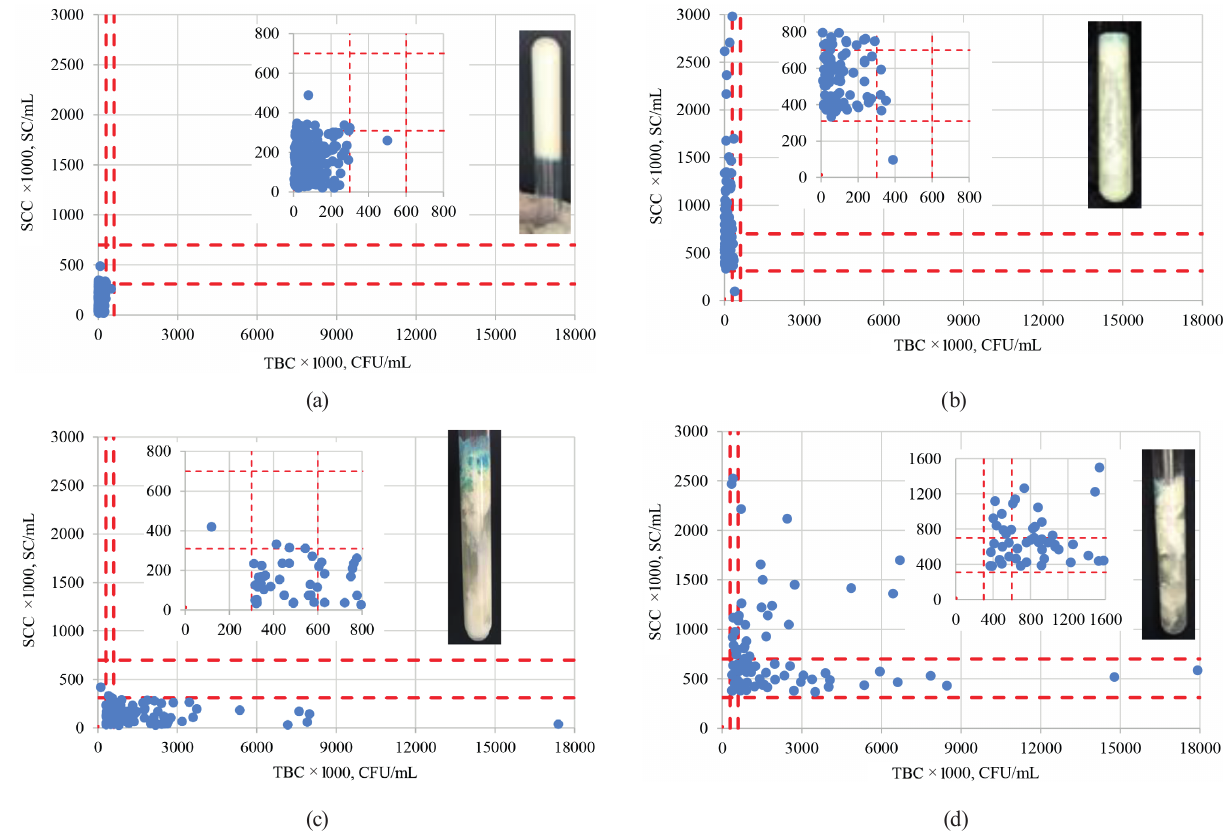
Figure 6 Correlation between the MBRTe and TBC + SCC (CFU or SC/mL, respectively). (a) MBRTe-I: n = 265 (37% of the total); (b) MBRTe-II: n = 130 (18% of the total); (c) MBRTe-III: n = 99 (14% of the total); (d) MBRTe-IV: n = 84 (12% of the